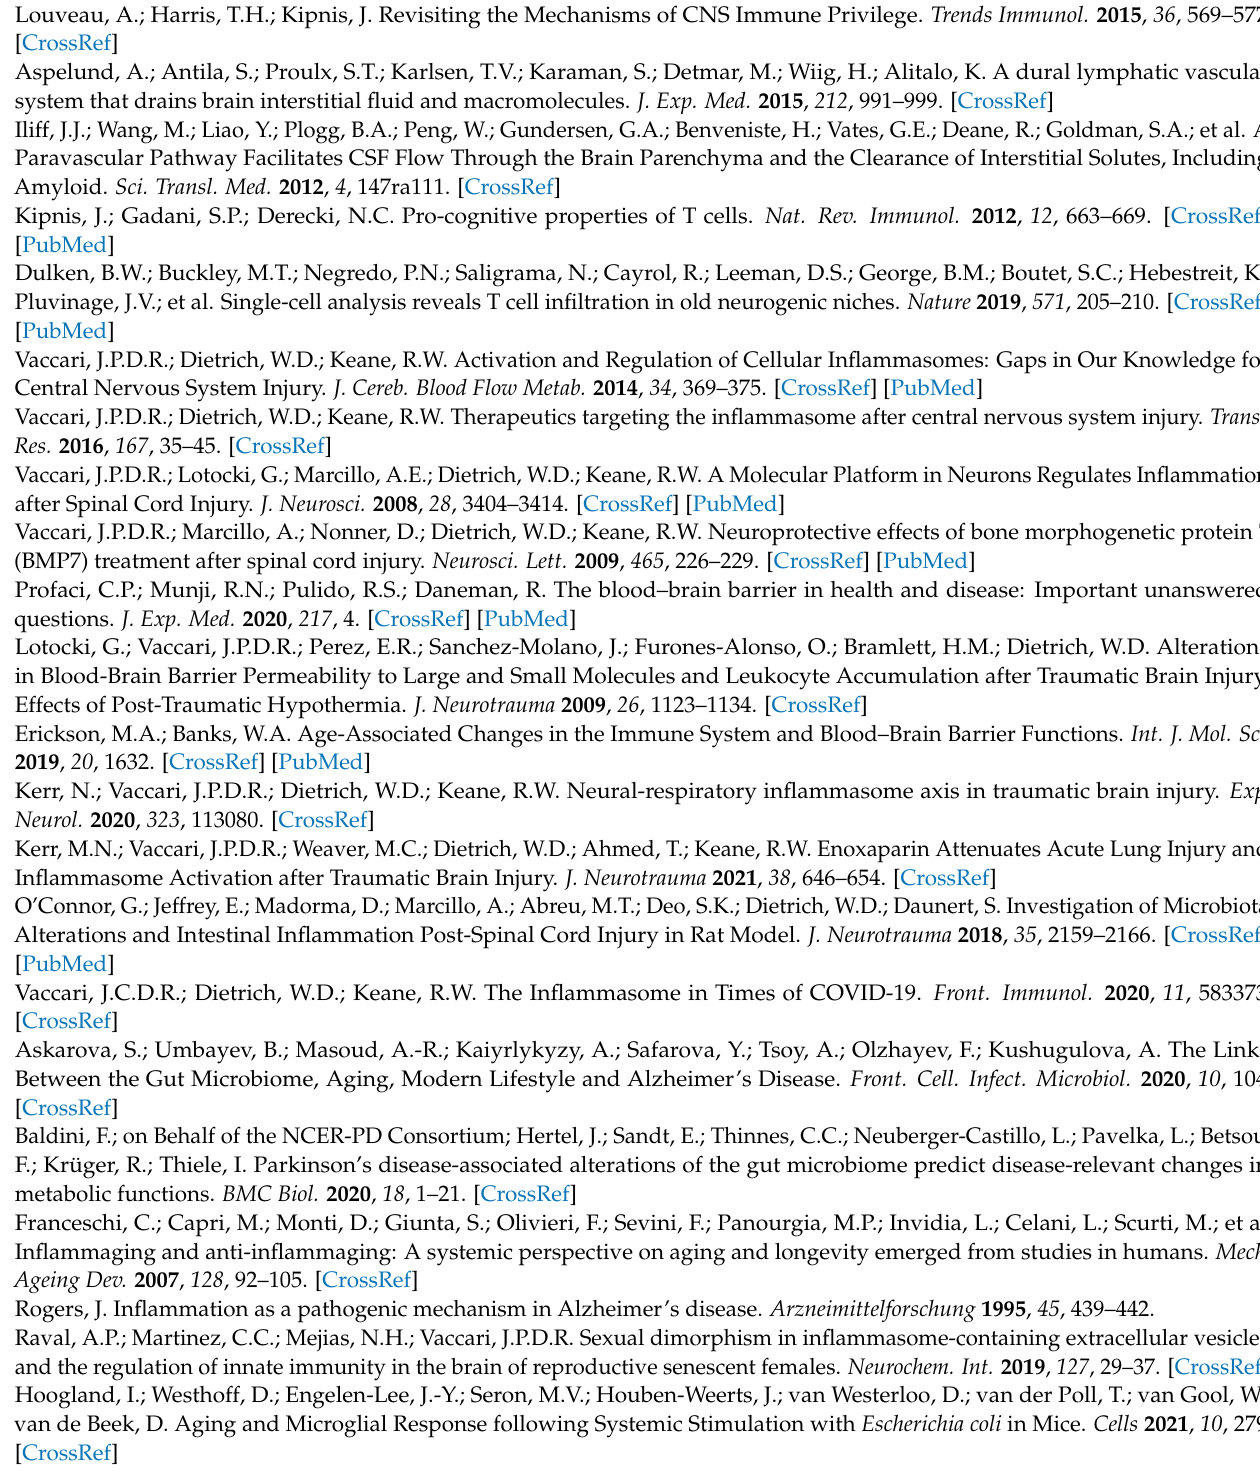
Acknowledgments: Figure was made with